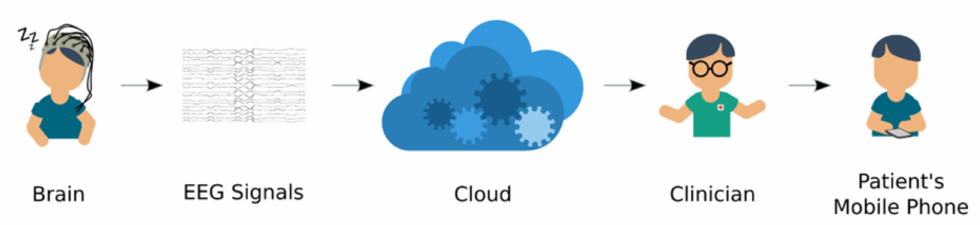
Figure 15. Block diagram of cloud-based sleep stage classification system using EEG